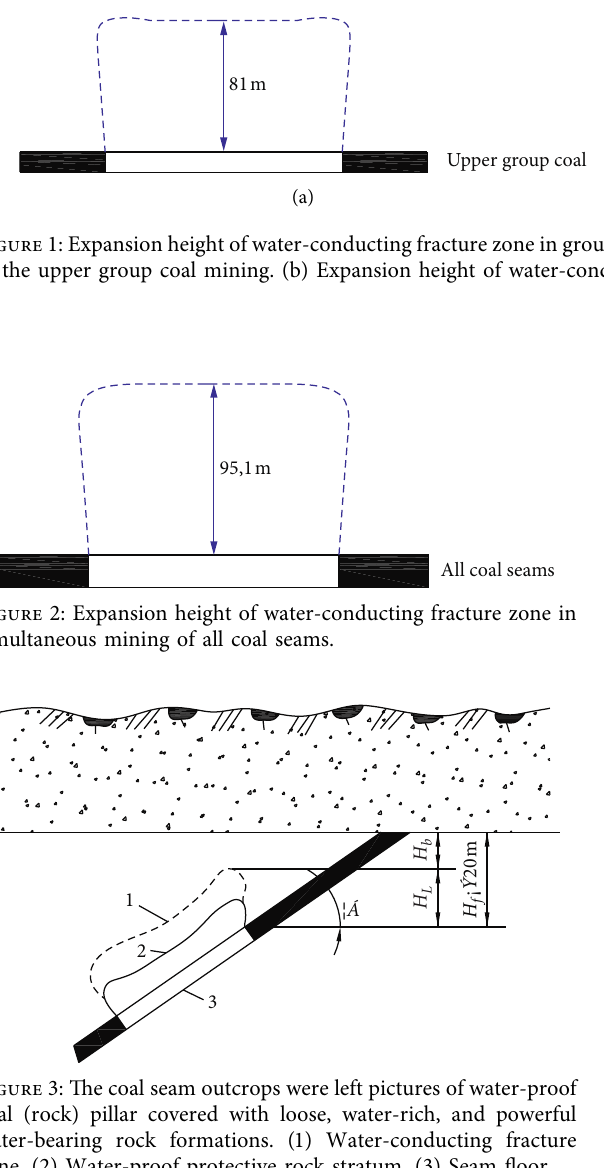
Figure 3: The coal seam outcrops were left pictures of water-proof coal (rock) pillar covered with loose, water-rich, and powerful water-bearing rock formations. (1) Water-conducting fracture zone. (2) Water-proof protective rock stratum. (3) Seam